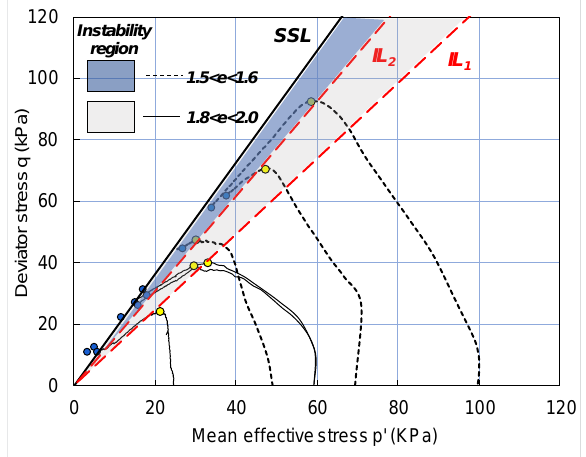
Figure 5. Instability lines and instability regions of specimens with di ff erent void